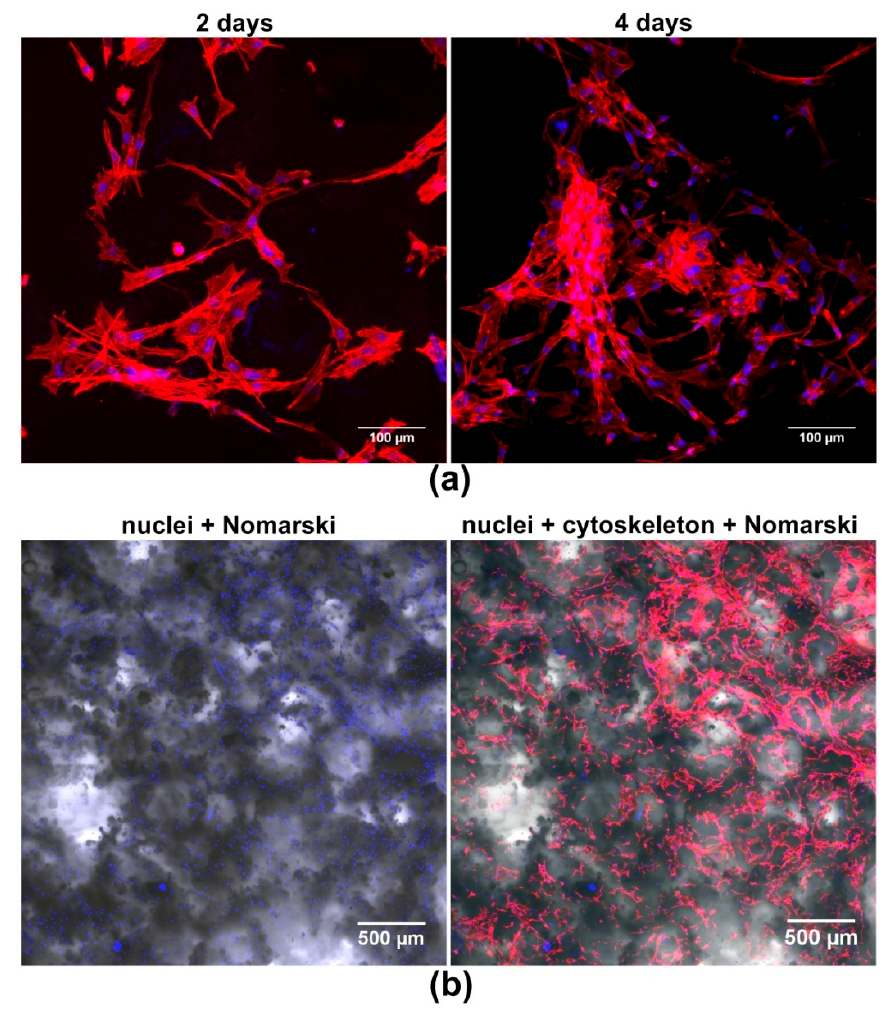
Figure 5. CLSM images presenting the growth of MC3T3-E1 osteoblasts on the surface of the mat_2_2 scaffold: ( a ) cell growth and morphology on the 2nd and 4th day, magnification 200×, scale bar = 100 µm; ( b ) lower magnification images showing structure of the biomaterial (thanks to applied Nomarski contrast) covered with osteoblasts, magnification 40×, scale bar = 500 µm (red fluorescence—cytoskeleton filaments, blue fluorescence—nuclei).